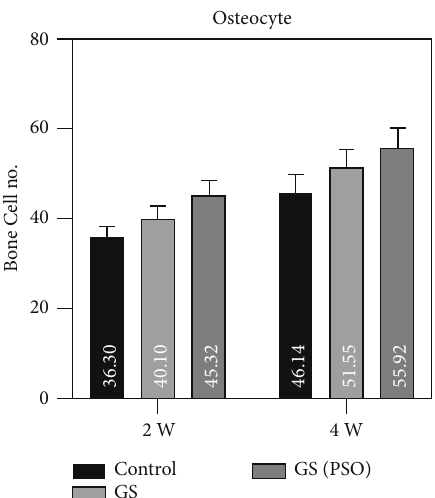
Figure 11: A bar chart representation of the mean and standard deviation of bone cells after 2- and 4-week time intervals, con- sidering